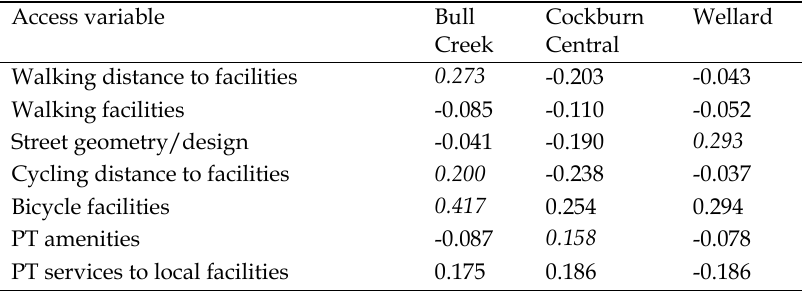
Aggregated local access by precinct (weighted by number of households) Access